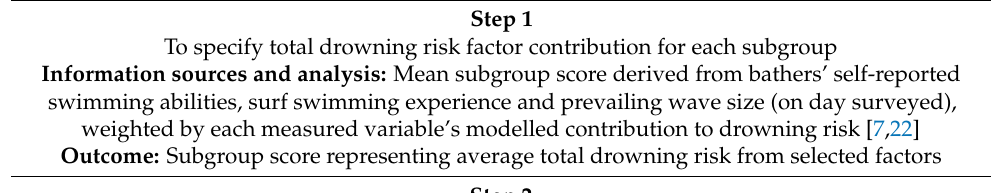
Table 2. Conceptual summary of study